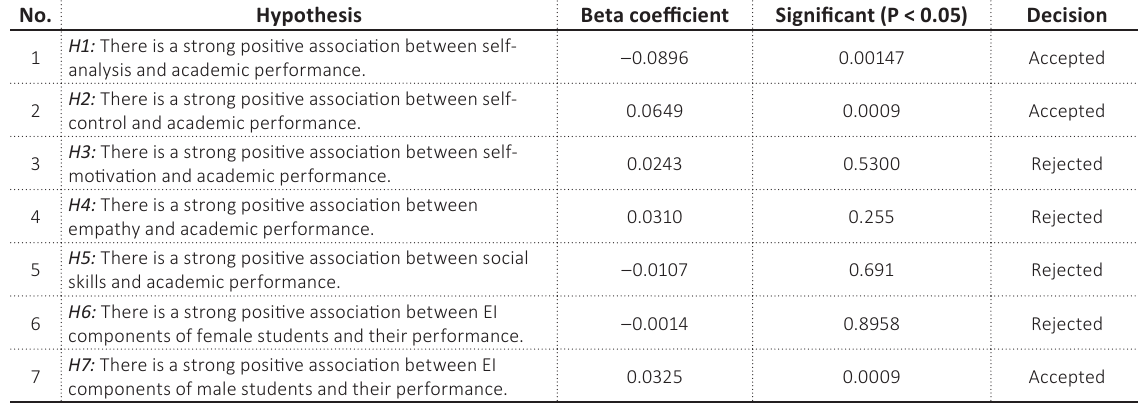
Table 6. Male and female student’s performance with EI components